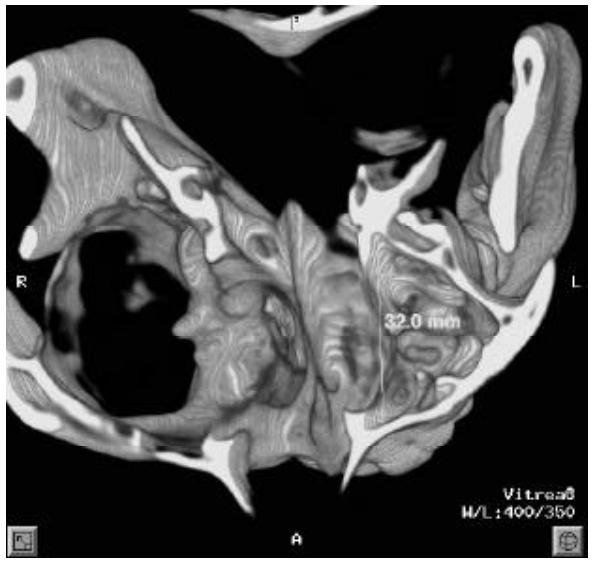
FIGURE 2- 3D-CT supero-inferior view using bone protocol is demonstrating the electronically measurement of the left maxillary sinus’ antero-posterior largest diameter (32.00 mm)